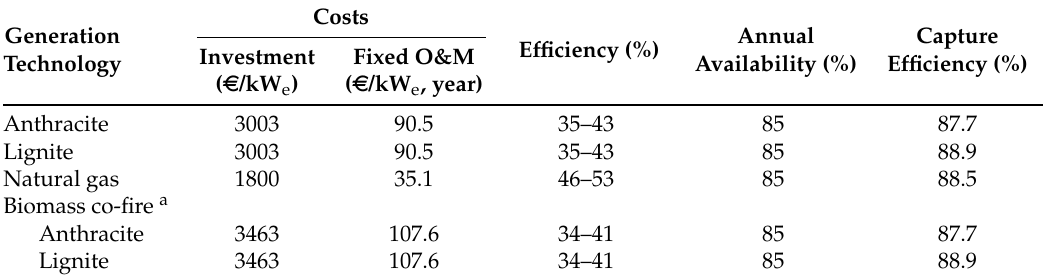
Table A2. Base input data and assumptions for thermal electricity generation technologies with carbon capture and storage (CCS) available for investment in the ELIN model. Investment costs come from [22]. Technical lifetimes are assumed to be 40 years for all CCS technologies (based on the assumptions in [30]).